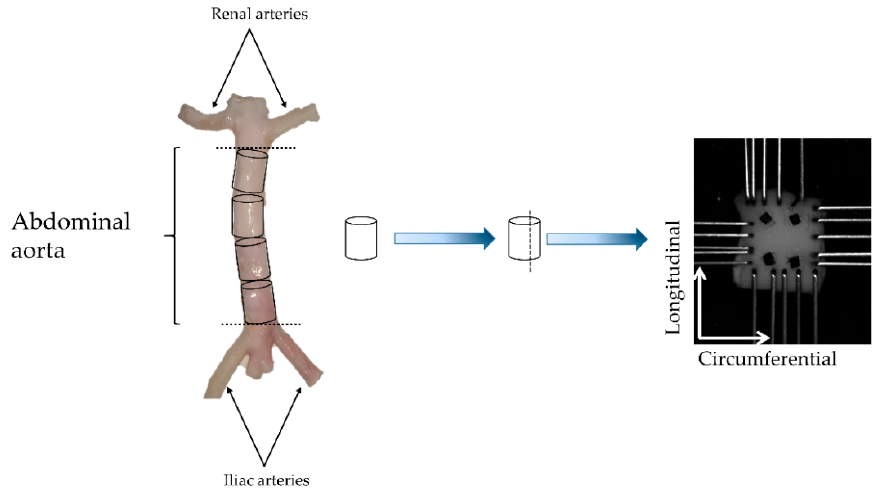
Figure 1. Exemplary schematic for specimen procurement. Each specimen consisted of a cylindrical ring approximately 7 mm long, which were subject to planar biaxial tensile testing. N = 6 specimens per group were tested using a CellScale BioTester ® while submerging the specimen in saline solution at 37 °C.